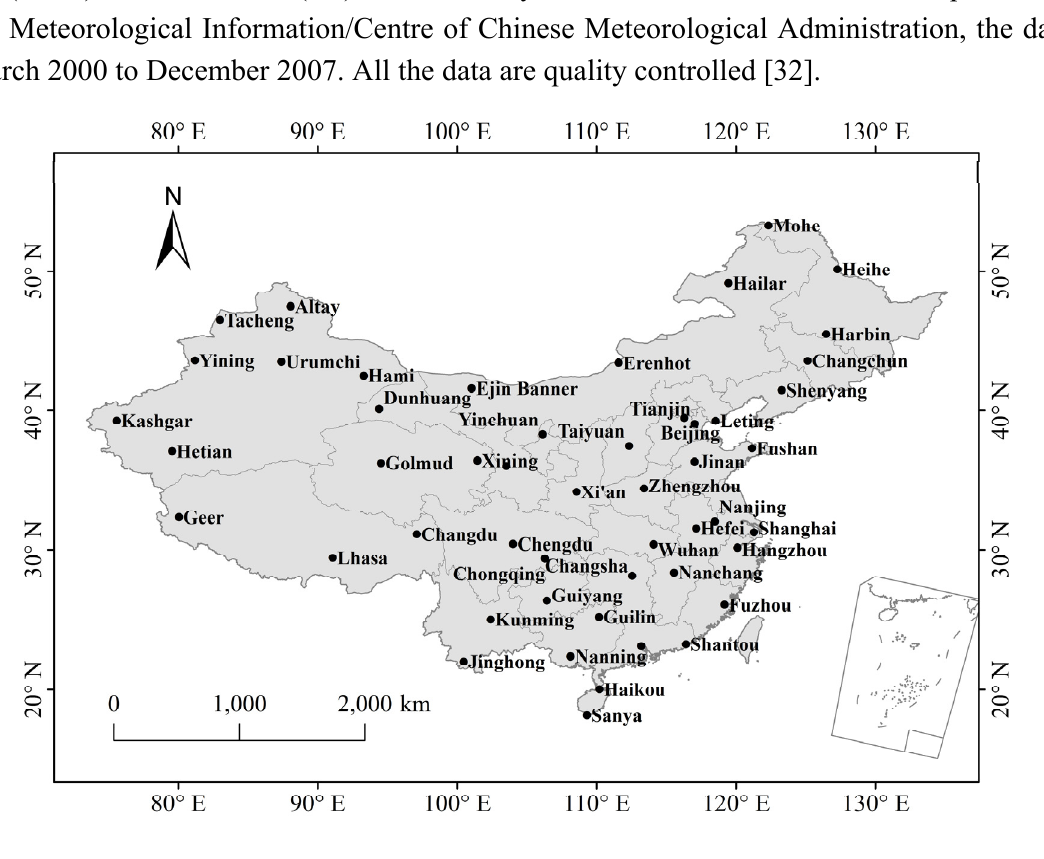
Figure 1. Distribution of Chinese meteorological sites used in the present